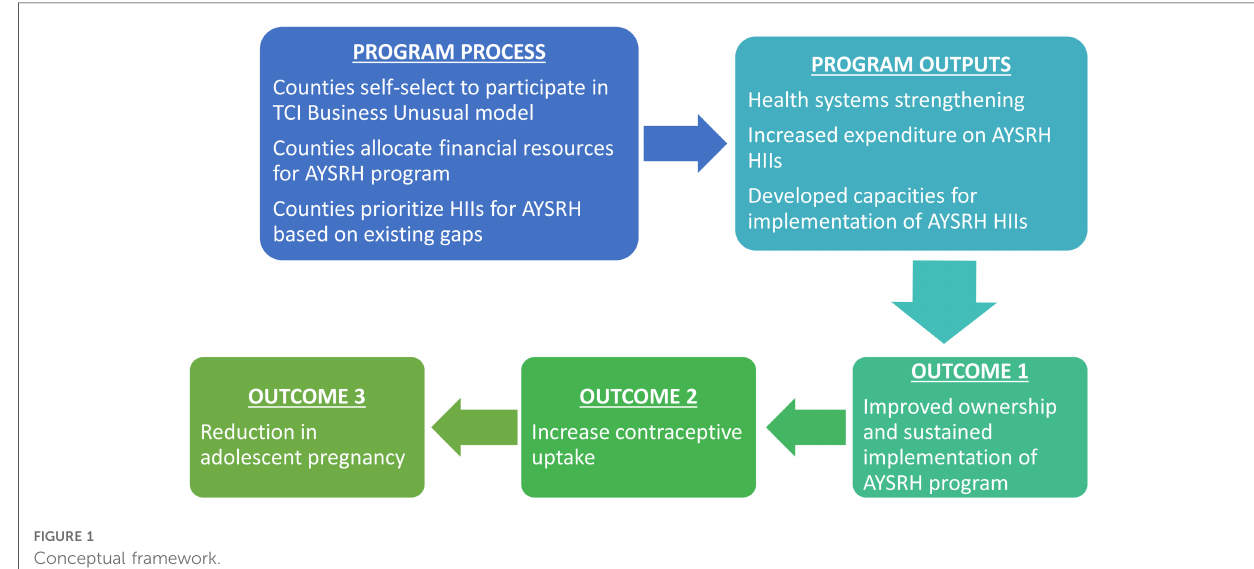
FIGURE 1 Conceptual